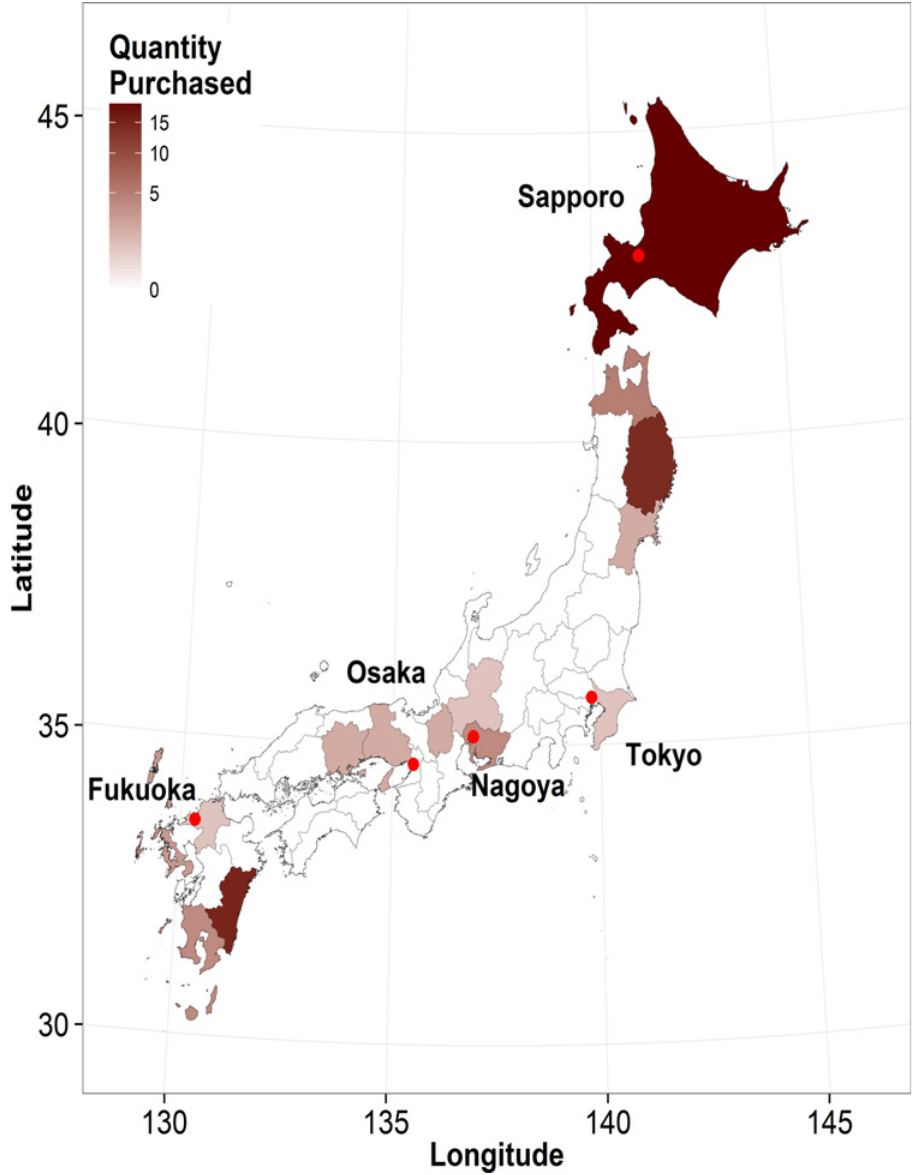
Fig 1. Map of Japan showing the study area. A choropleth map of 46 Japanese administrative areas (prefectures) showing the origin of the purchased domestic chicken products and the quantity of products supplied from each prefecture. The origin of 82 domestic products (52.6%) was unavailable and is not shown. The superimposed points show the locations of the 5 Japanese cities where chicken products were purchased between July and August